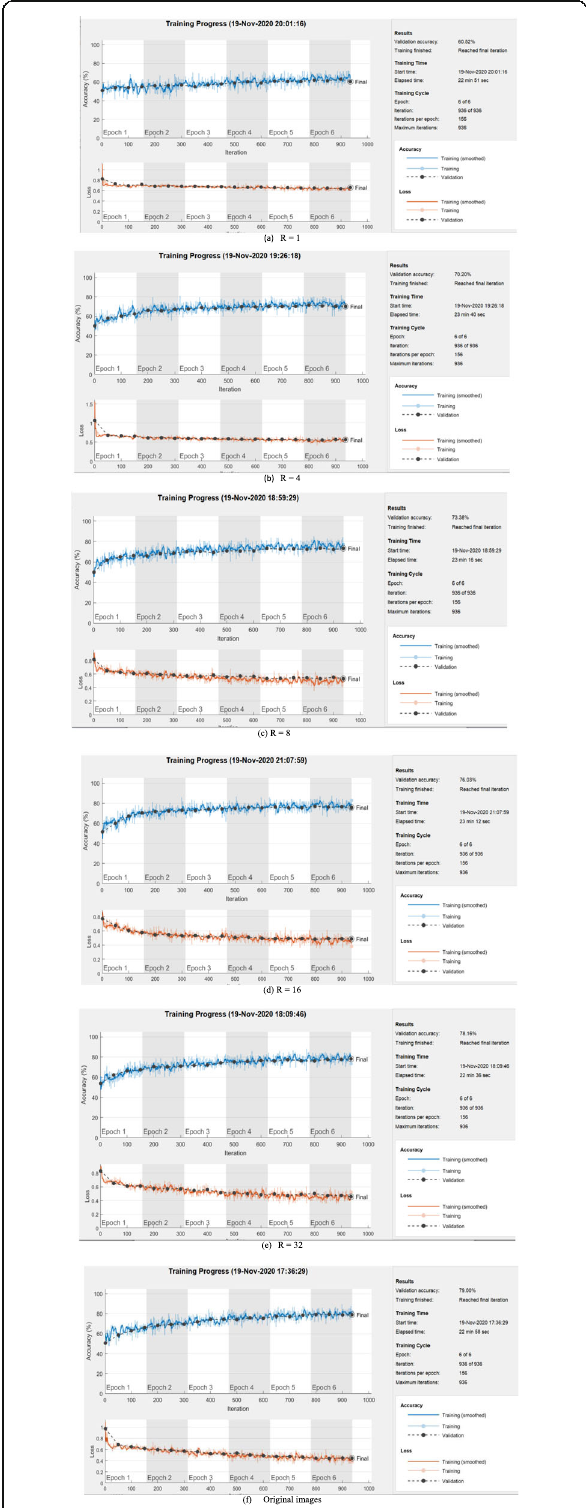
Fig. 4 Accuracy of the CNN classification result at R Rank-1 and Original images and R = 1, 4, 8, 16 and